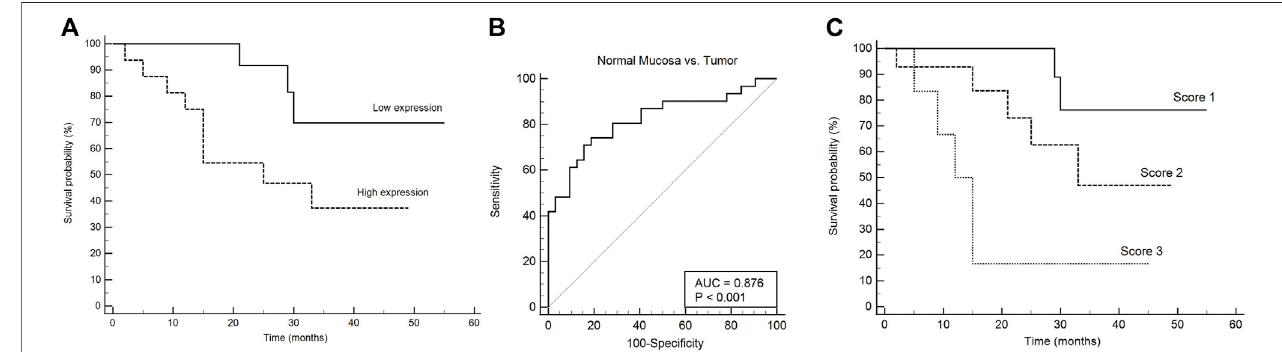
FIGURE 2 | HPSE1 overexpression discriminates OSCC and normal samples and predicts low patient survival. (A) Kaplan – Meier cumulative curves for disease-free survival of patients with OSCC as a function of HPSE1 expression, showing a 70% probability of death in patients with higher expression of HPSE1 compared with those with low expression. (B) Receiver operating characteristic (ROC) curves showing the ability of the HPSE1 overexpression distinguishes OSCC tumors from normal oral samples. (C) Kaplan – Meier of multivariate survival analysis combining HPSE1 expression levels with pT stages, where score 1: HPSE1 lower expressing samples associated with pT1/2, score 2: HPSE1 lower expressing samples associated with pT3/4 or higher HPSE1 with pT1/2, and score 3: HPSE1 higher expressing samples associated with pT3/4. These results con fi rmed that HPSE1 overexpression was signi fi cantly associated with higher grade